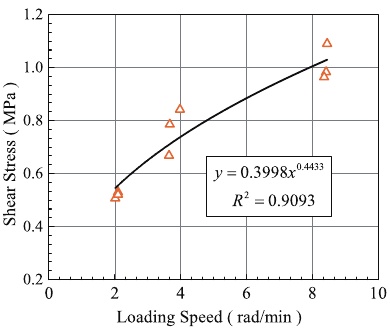
Figure 12. Test speeds’ dependency of shear stress. Table 6. The fitting function of the cohesion with the temperature/loading